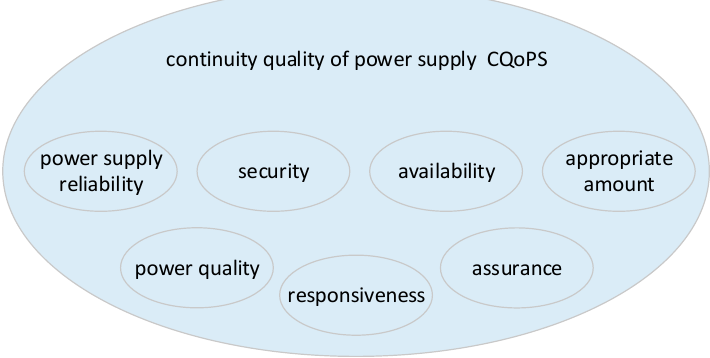
Figure 4. CQoPS components (own elaboration on the basis of [41]).